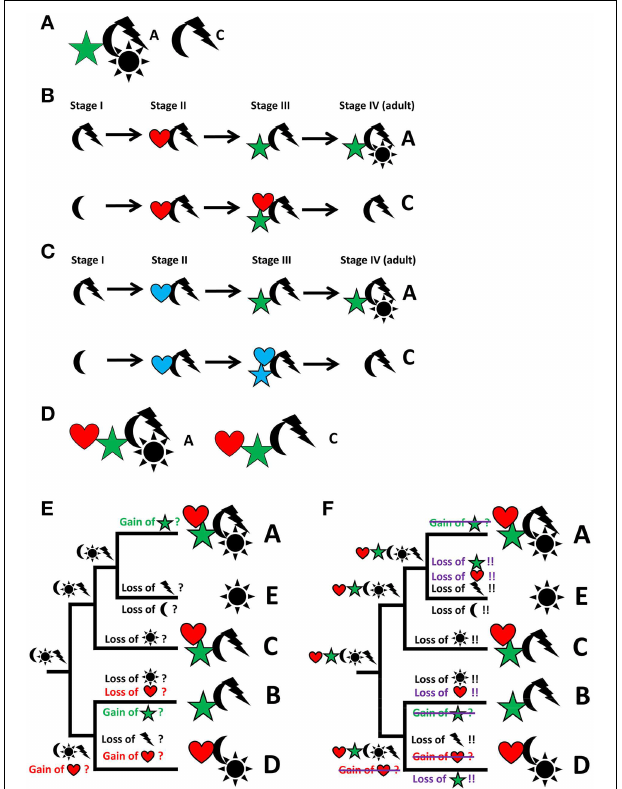
FIGURE 2 | From descriptive science to reconstruction of character evolution by integrating descriptive data, developmental biology, and phylogeny. Particular focus is on the evolution of the characters “star” and “heart,” which are therefore depicted in color. Characters or character states are represented by symbols, taxa by letters. (A) Two individual taxa (A,C) can be discriminated by different sets of characters. (B) Analysis of ontogeny reveals the ontogenetic emergence or loss of characters. (C) Ontogenetic analysis may reveal transitory characters, i.e., characters that appear during ontogeny but are lost prior to adulthood (marked in blue; “heart” in taxon A and both, “heart” and “star,” in taxon C). (D) All characters, including transitory characters, belong to the “body plan” of a taxon. Note that this discussion can be extended into extinct lineages known from the fossil record, thereby increasing taxon sampling and adding the dimension of time to the discussion. (E) Hypothesized scenario of character evolution identical to Figure 1D , i.e., not taking transitory characters into account. (F) Significantly altered hypothetical scenario of the reconstruction of character distribution and gain and loss events at different nodes and along the various lineages due to the incorporation of transitory characters. Events that differ from the scenario in E are either crossed out or added in